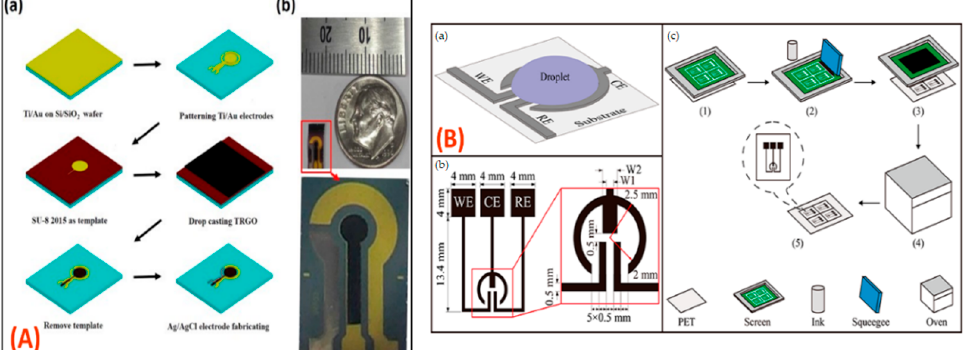
Figure 9. ( A ) ( a ) Schematic illustration of the fabrication of micro-patterned design with proposed heavy-metal-detection sensor with three electrodes and TRGO coating onto Au electrode; ( b ) pho- tomicrograph of a miniaturized and completely integrated sensor [116]. ( B ) ( a ) Droplet-based electrochemical (EC) sensor design principle; ( b ) sensor component sizes and three-electrode arrange- ments; and ( c ) schematic illustration of the droplet-based sensor production technique using screen printing [117]. Reprinted from the above-mentioned references with permission of copyright from the respective journals.